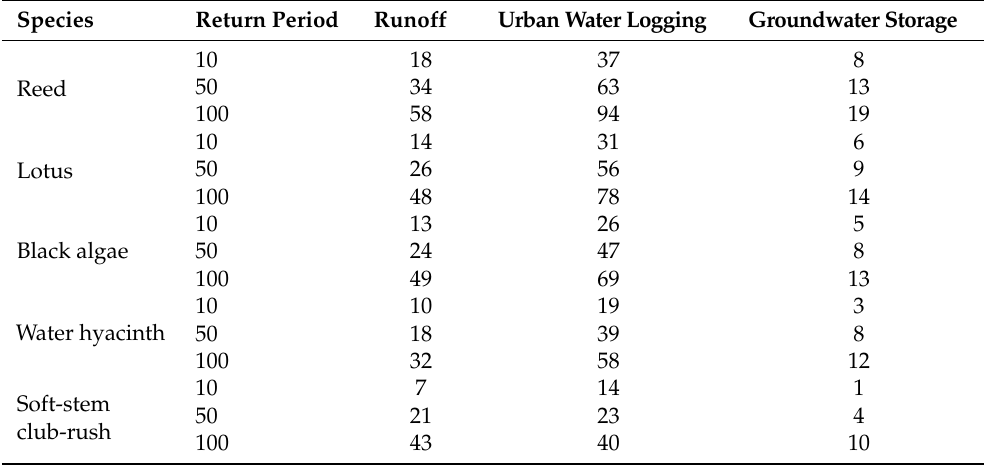
Table 1. Impact of aquatic plants on urban water characteristics.